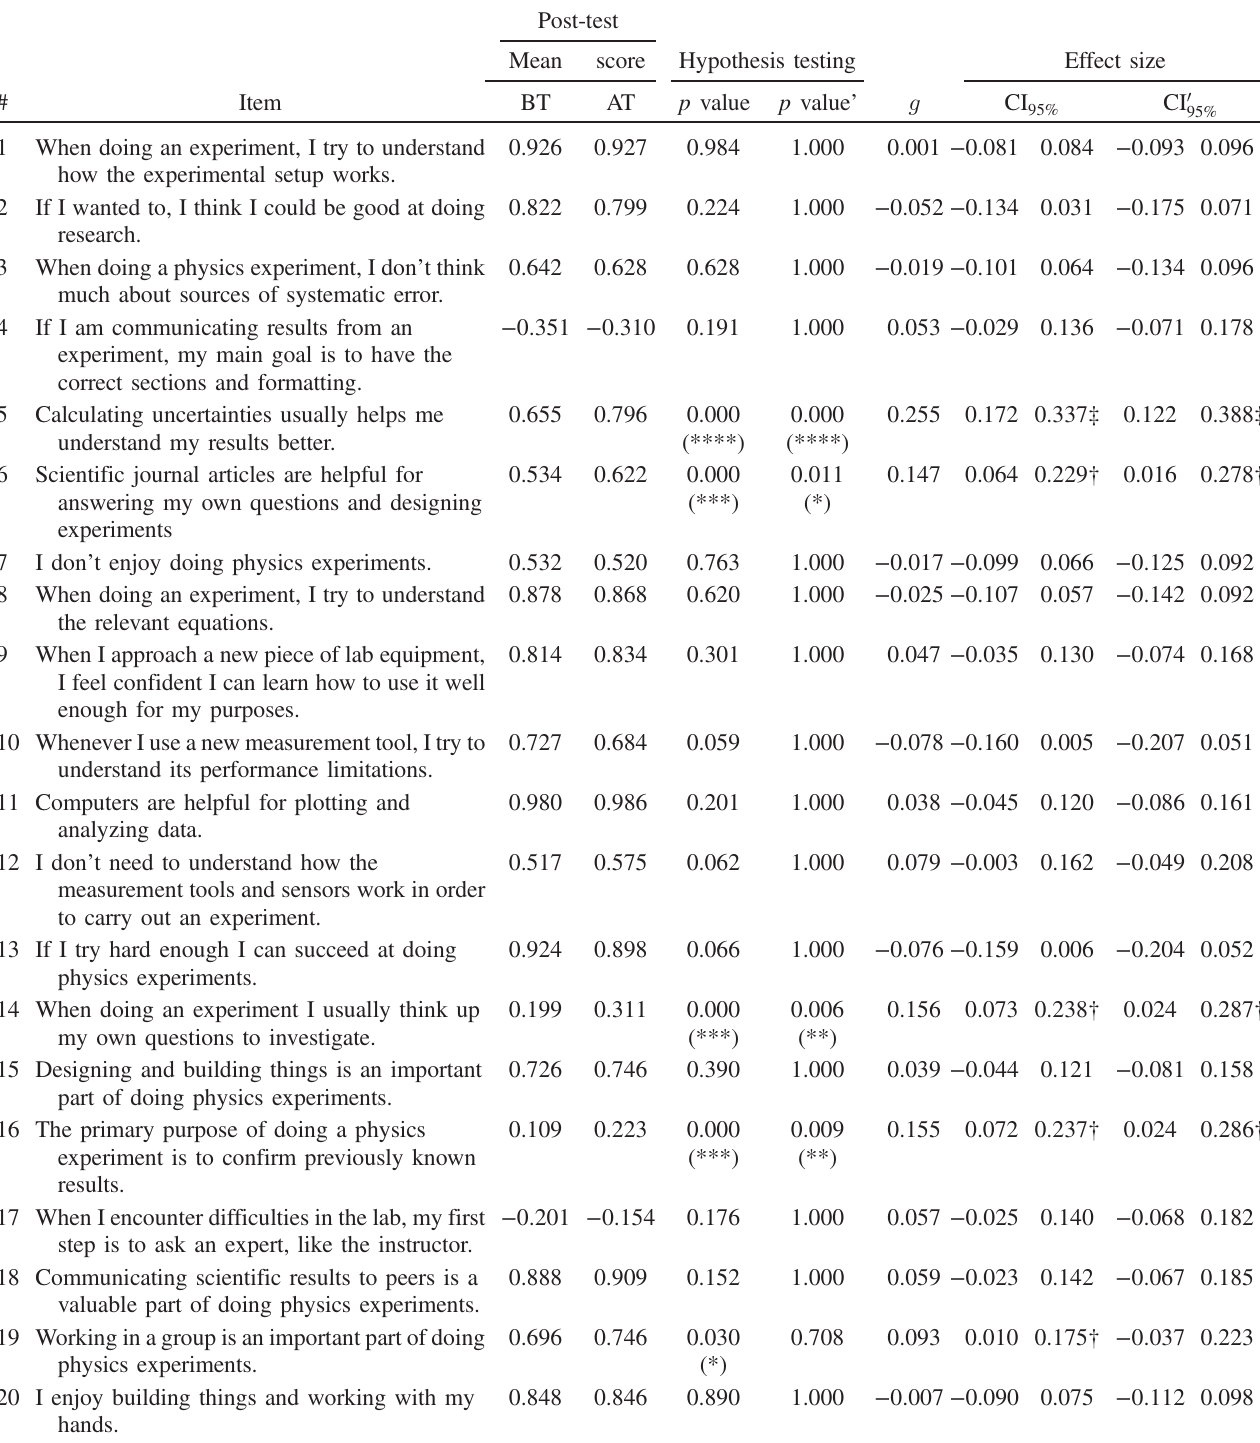
TABLE XI. E-CLASS items compared between BTand AT scores for men as plotted in Figs. 6 and 7. The p values are adjusted using the Holm-Bonferonni correction and the CI 0 95% on the effect size are adjusted using the Ryan-Holm step-down Bonferroni procedure. Significance of p values are given by (*) for p ≤ 0 . 05 , (**) for p ≤ 0 . 01 , (***) for p ≤ 0 . 001 , and (****) for p ≤ 0 . 0001 . The † indicates a small, nonzero effect size ( g < 0 . 2 ), while ‡ denotes a medium, nonzero effect size ( 0 . 2 ≥ g < 0 . 8 ). There are no large effect sizes from this